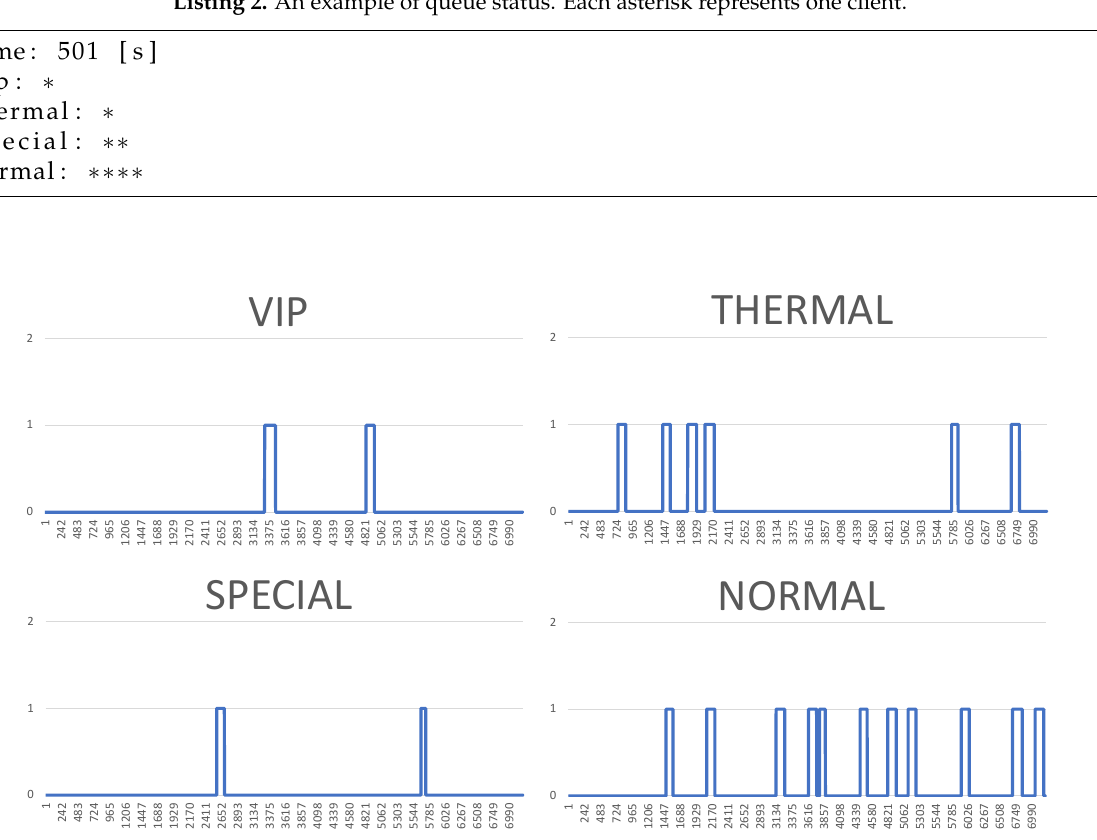
Figure 10. Results of the simulation processes carried out, or queue loads over the simulation time—low mode. (Horizontal axes show the passing of simulation time from 0 to approx. 7000 s, vertical axes illustrate the current number of clients in particular